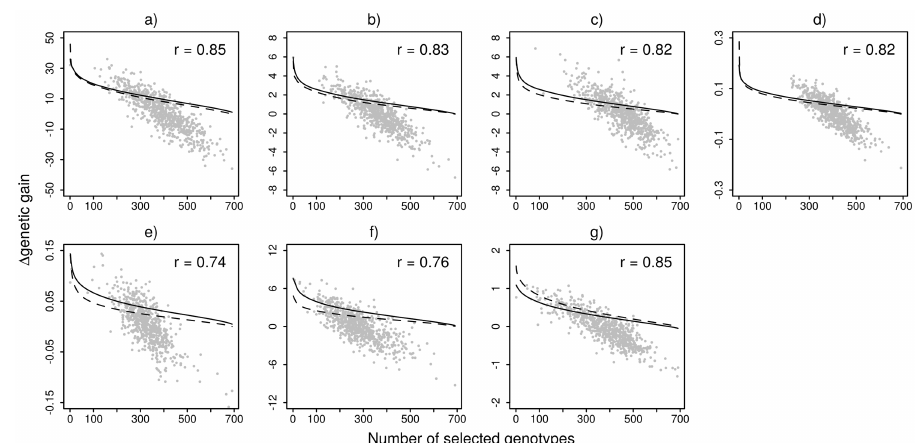
Fig 4. Correspondence of estimated genetic gain and breeding values. Correspondence of geneticgain and breedingvalues estimated on the basis of information from pedigree(dashedline) or from sib-ship reconstruction (solidline); a) Wood density [kg/m3], b) Growth strain 1.4-3 m log [mm], c) Growth strain 3-6 m log [mm], d) Stiffness 1.4-3 m log [km/s], e) Stiffness 3-6 m log [km/s], f) Diameter at breast height [mm], g) Tangential air-dry shrinkageaverage3-6 m log